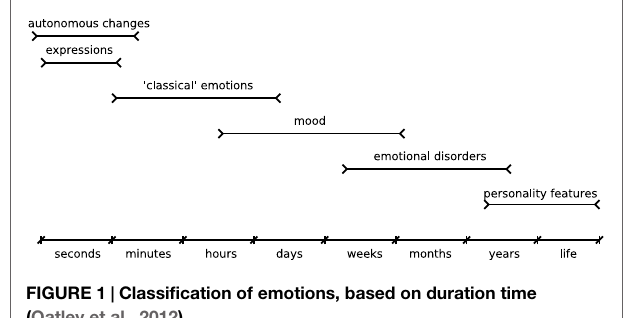
FIGURE 1 | Classification of emotions, based on duration time (Oatley et al., 2012)